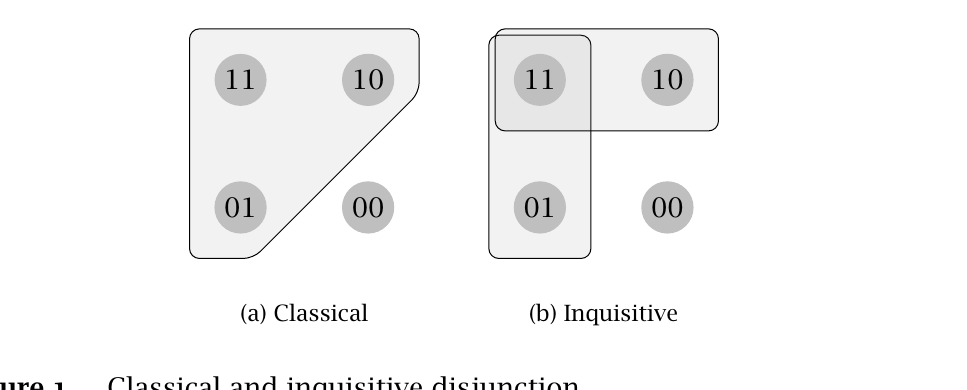
Figure 1 Classical and inquisitive